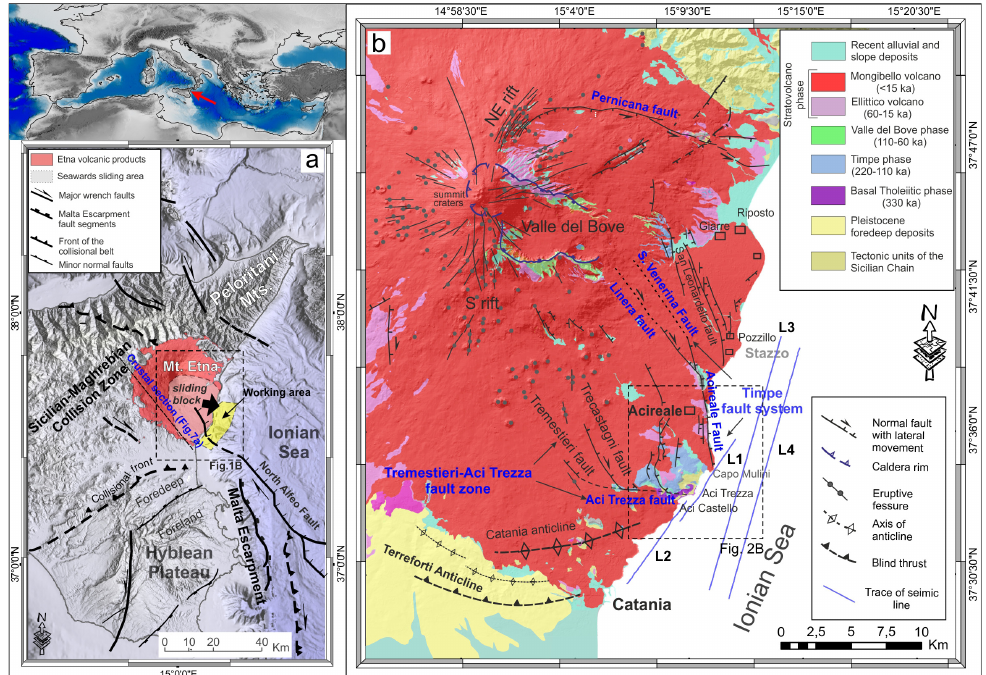
Figure 1. ( a ) Tectonic sketch-map of eastern Sicily and Ionian offshore. The Mt. Etna Volcano (red area) lies mainly at the top the Sicilian-Maghrebian Collision Zone, a fold and thrust belt sandwiched between the Peloritani Block in the North and the Hyblean Foreland in the south. Major tectonic boundaries in the Ionian Sea (e.g., the Malta Escarpment and the North Alfeo Fault [13] appear to merge in the Mt. Etna area); ( b ) Structural framework of the eastern and southern flanks of Mt. Etna, showing a complex deformation field resulting from volcano-tectonic processes, sliding block dynamics and regional tectonics. L1–L4, high-resolution seismic dataset used in this